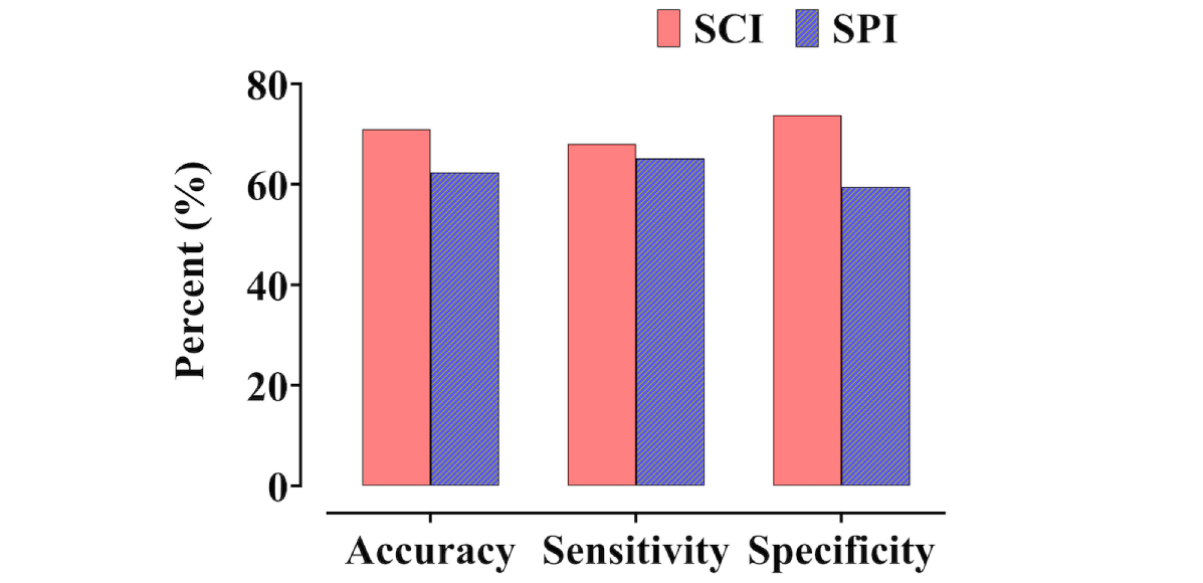
Figure 4. Performance measures of spectrogram-convolutional neural network index (SCI, red) and the Surgical Pleth Index (SPI, blue) in terms of accuracy, sensitivity and specificity. Accuracy means balanced accuracy. Cut-off value of SCI was